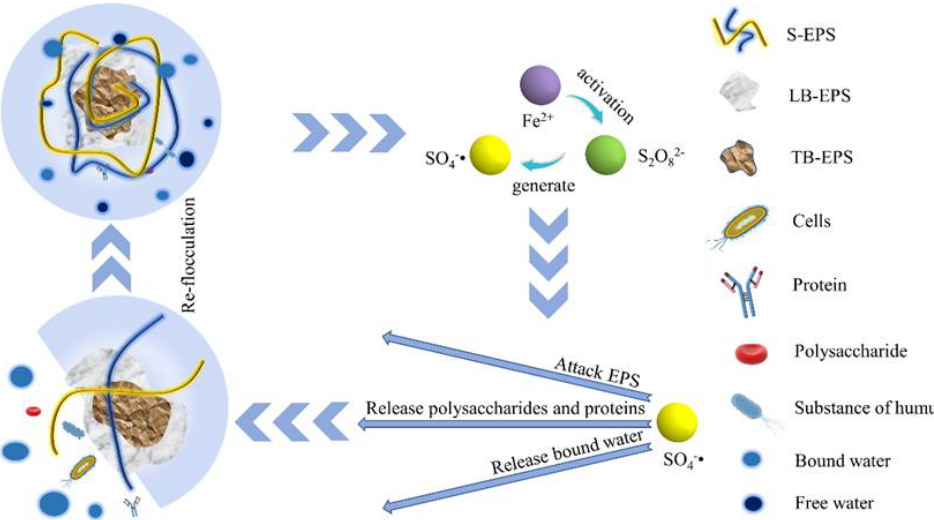
Figure 8. Fe 2+ Activated persulfate sludge conditioning mechanism.